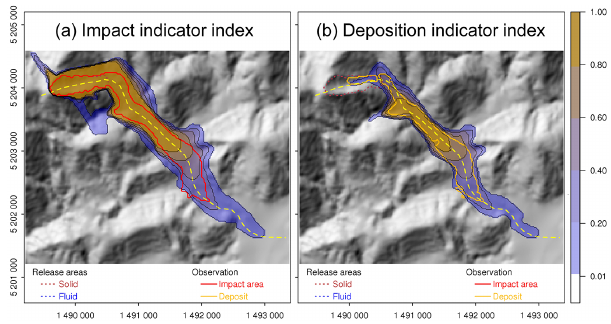
Figure 10. Results of Experiment 2A: (a) impact indicator index III and (b) deposition indicator index DII derived for the Acheron rock